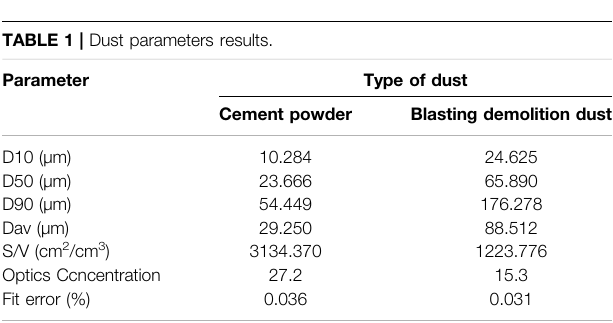
TABLE 1 | Dust parameters